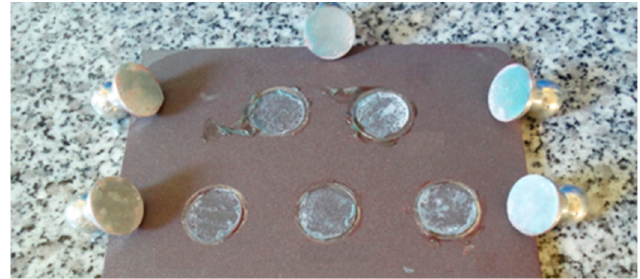
Figure 5. The mode of failure of tested specimens.